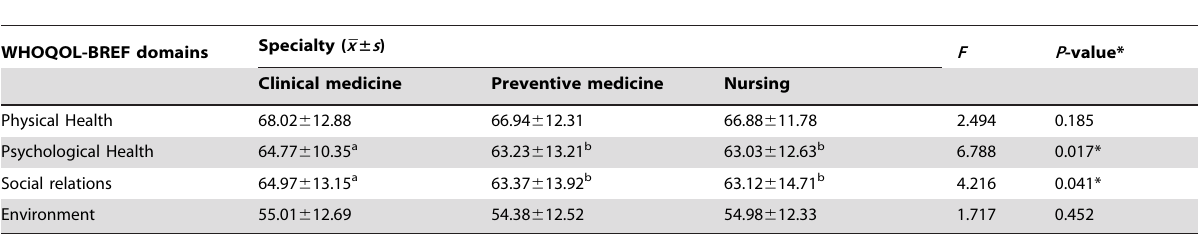
Table 4. Scores of medical students in different specialties.